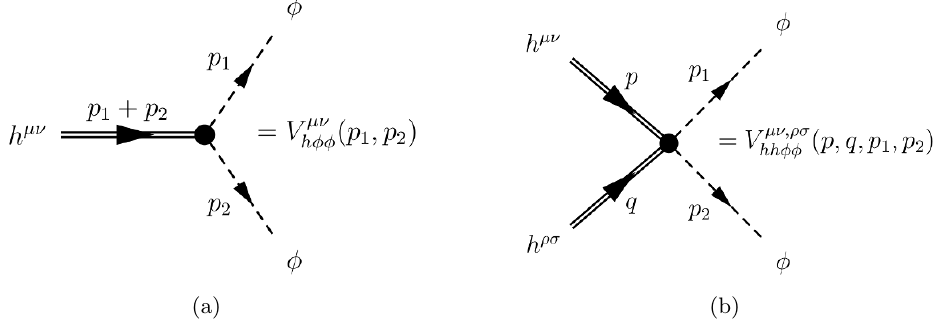
Figure 6 . Feynman rules for the vertices of the free scalar